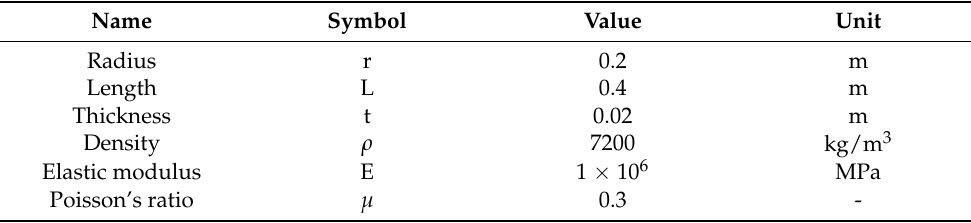
Table 2. Parameters of the hollow